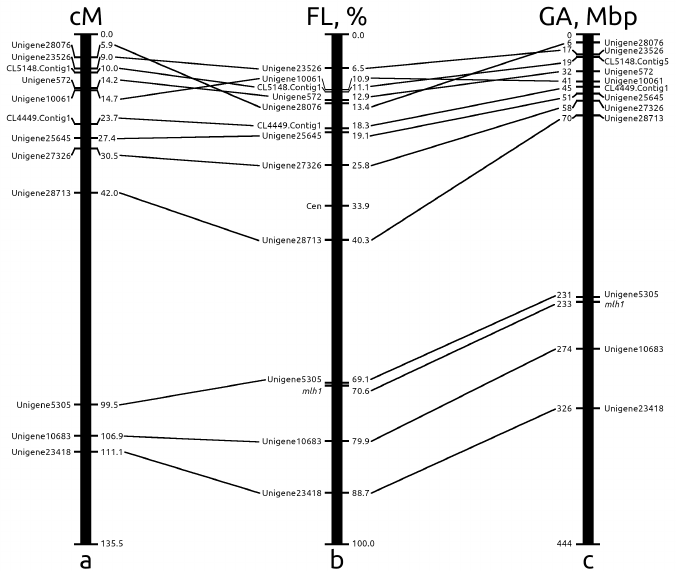
Figure 5. Alignment of the genetic, chromosomal and pseudochromosome maps of onion chro- mosome 2: ( a ) the position of Tyr-FISH markers on genetic map of the linkage group 2 described by [29]; distances in centiMorgans are shown on the right of linkage group; ( b ) the positions of Tyr-FISH mapped markers on physical chromosome are expressed as percentage of the fractional length (FL—distance from the telomere end of the short arm to the signals divided by the length of the entire chromosome); ( c ) the positions of Tyr-FISH markers on pseudochromosome 2 described by Finkers et al. [25] are expressed as the position of a gene sequence possessing of Tyr-FISH marker within one Mbp bin of pseudochromosome 2 (a total size of pseudochromosome 2–444